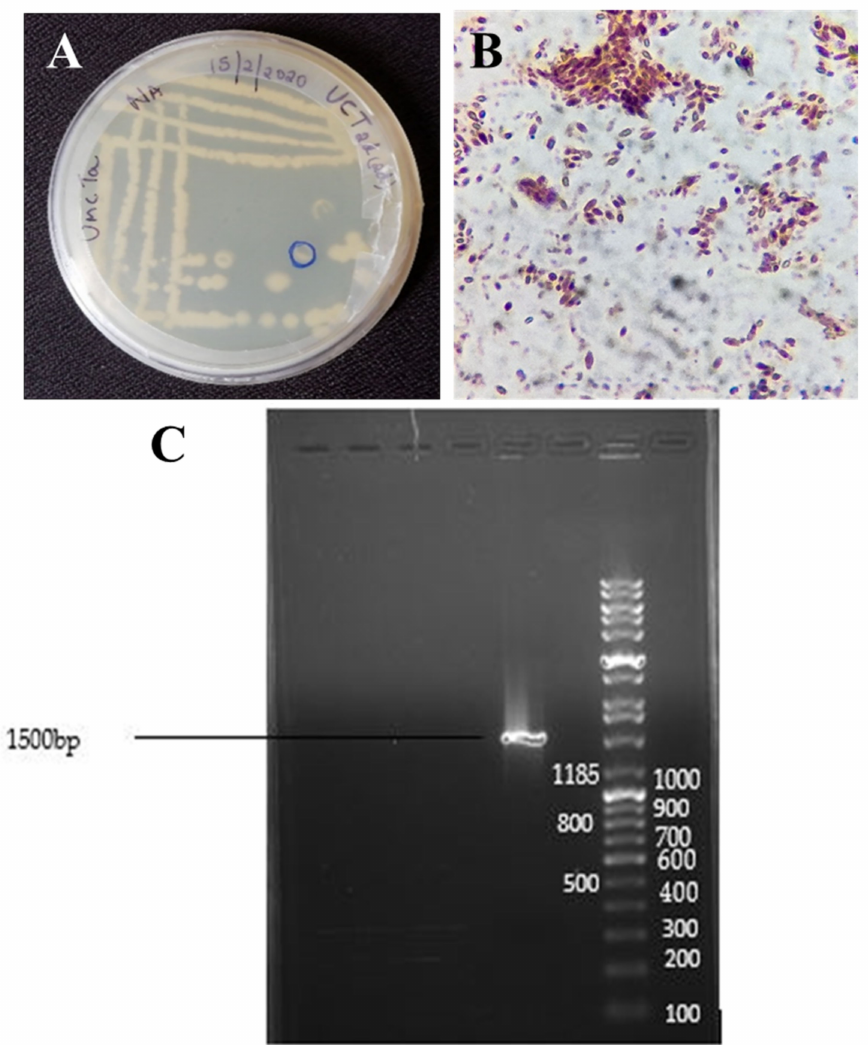
Figure 1. ( A ) Pure culture of isolated Endophytic bacteria from the bark samples. ( B ) Gram staining of isolated endophytic bacteria. ( C ) Agarose gel electrophoresis of the PCR product obtained from the 16SrRNA gene from endophytic